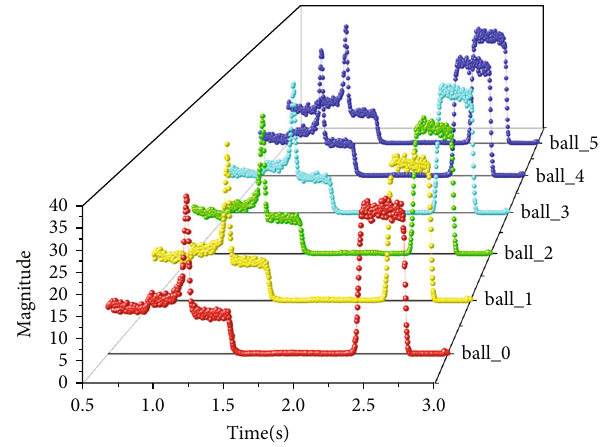
Figure 7: The plot of tracking error of the system using predicted data for tracking during uniformly accelerated motion of a table